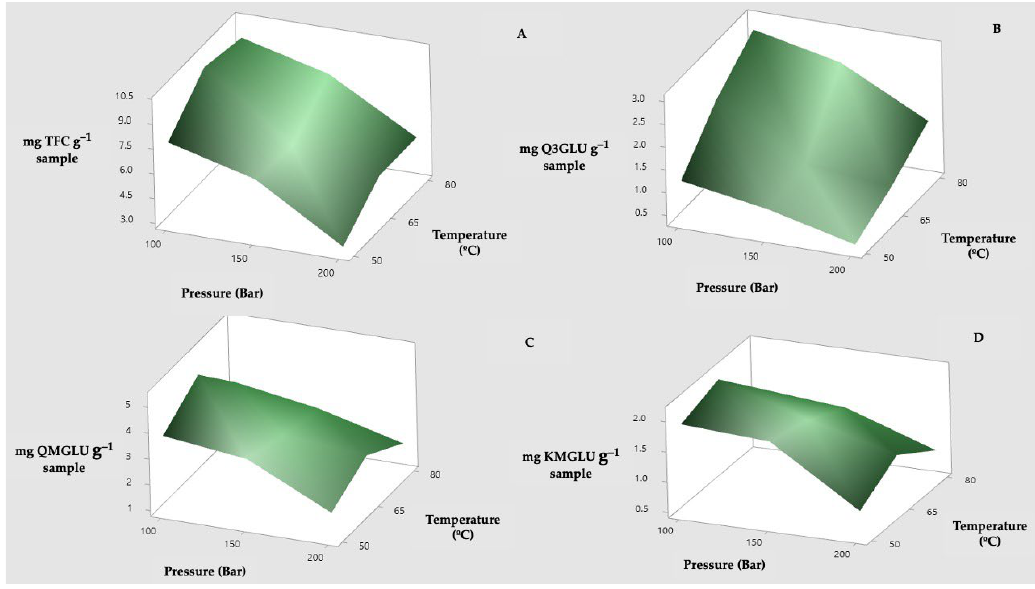
Figure 3. Response surface plots of TFC ( A ), Q3GLU ( B ), QMGLU ( C ) and KMGLU ( D ) concentrations for the different temperature and pressure levels in the study.